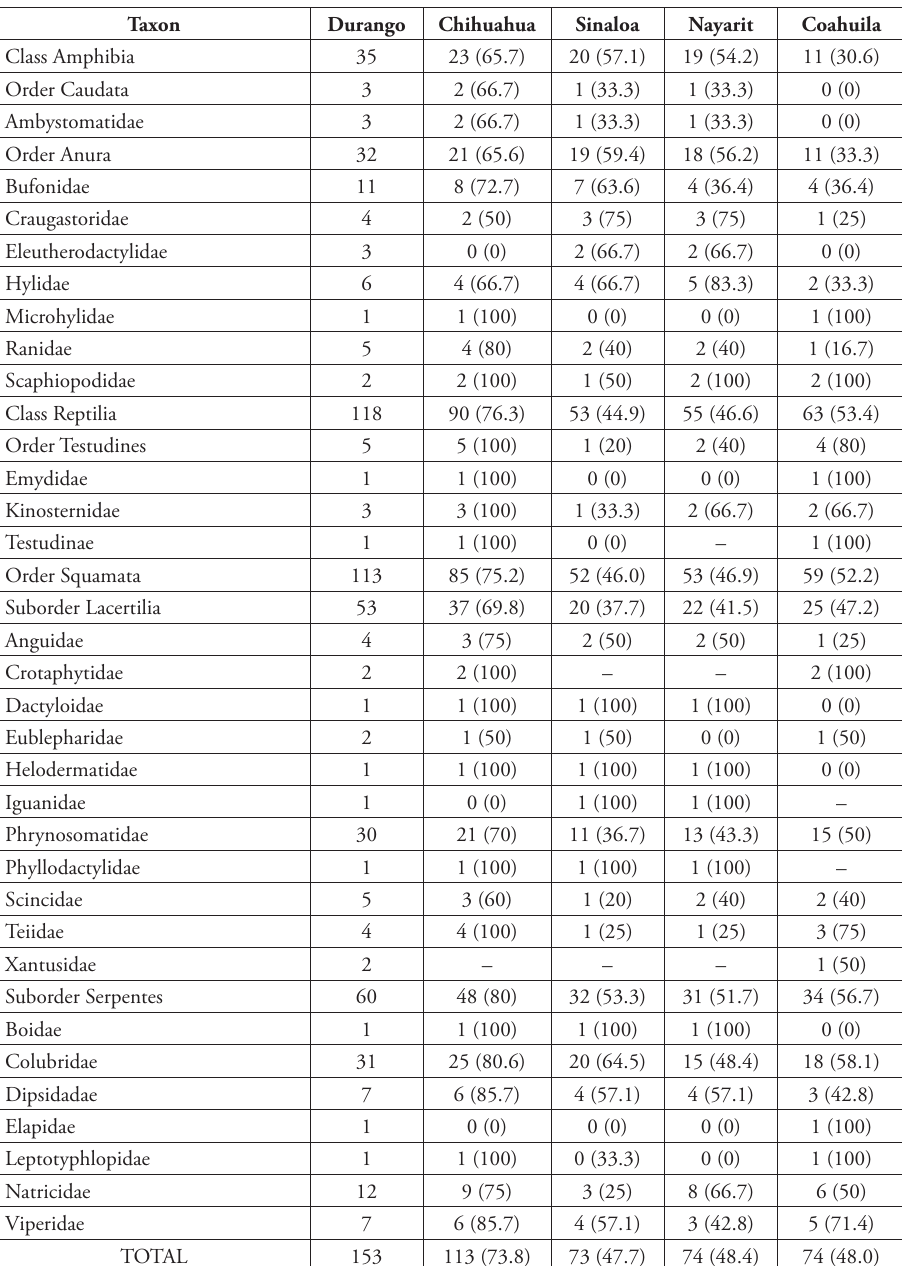
Table 4. Summary of the numbers of species shared between Durango and neighboring Mexican states (not including introduced species). The percent of species from Durango shared by a neighboring state are given in parentheses. – indicates either Durango or the neighboring state has no species in the taxonomic group, thus no value for shared species is